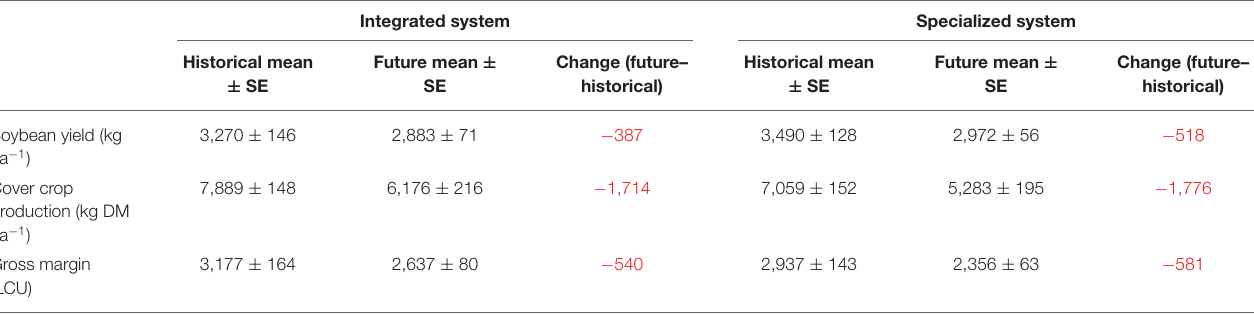
TABLE 1 | Predicted mean and change in mean soybean yield, ryegrass cover crop aboveground biomass production, and gross margins from historical (1961–2017) to future (2020–2060) simulation periods for integrated (grazed cover crop) and specialized (ungrazed cover crop) systems. Integrated